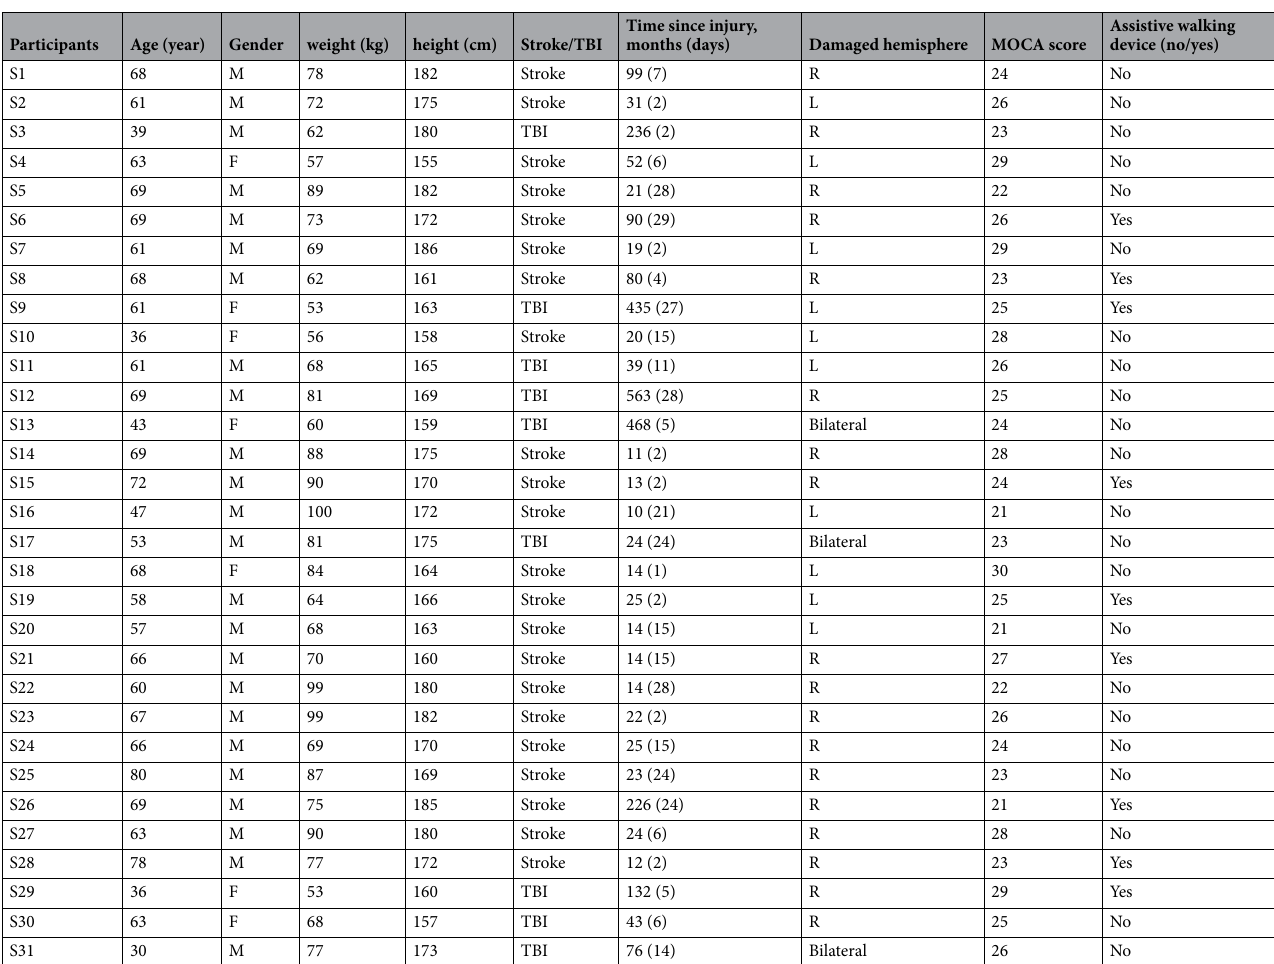
Table 2. Baseline Characteristics of each participant. F female, M male, TBI traumatic brain injury, R right, L